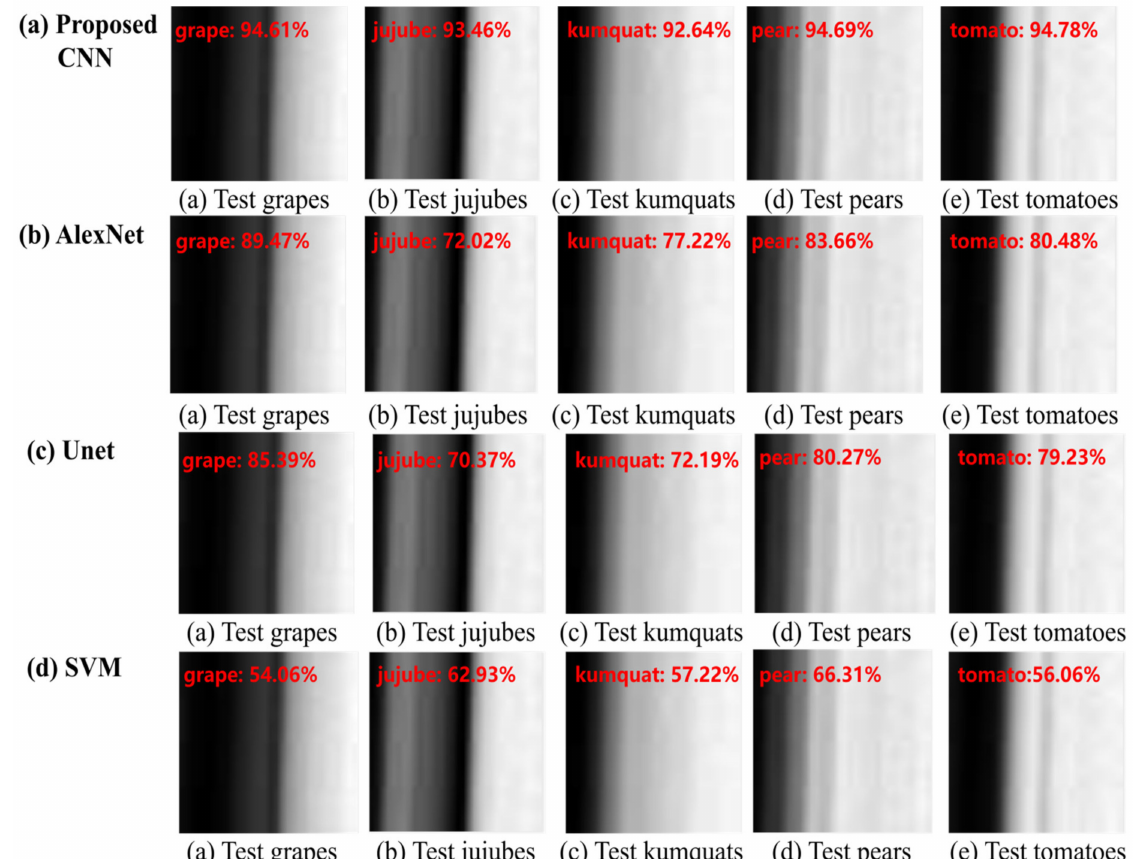
Figure 12. ( a ) The maximum testing results of the proposed CNN are between 90% and 95%. ( b , c ) The maximum testing results of AlexNet and Unet are between 70% and 90%. ( d ) The maximum testing results of the SVM are between 50% and